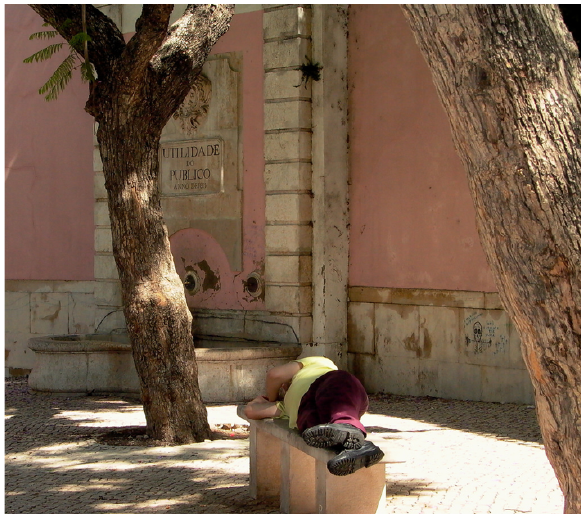
Figure 11. Photograph classified as “Maybe useful” regarding